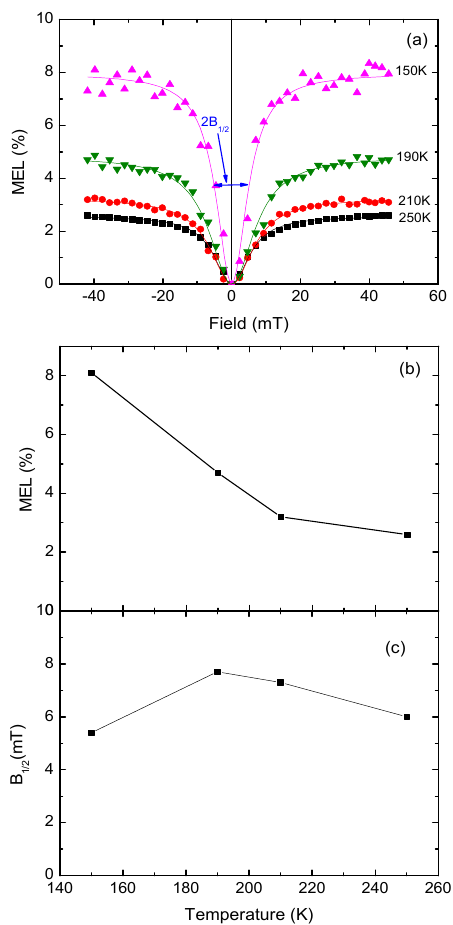
Figure 5. ( a ) The MEL curves of LEC sample at different temperatures (from 250 K to 150 K); ( b ) the MEL as a function of temperature in the LEC sample; ( c ) the temperature dependencies of the parameters B 1/2 for the MEL response, extracted from (a).